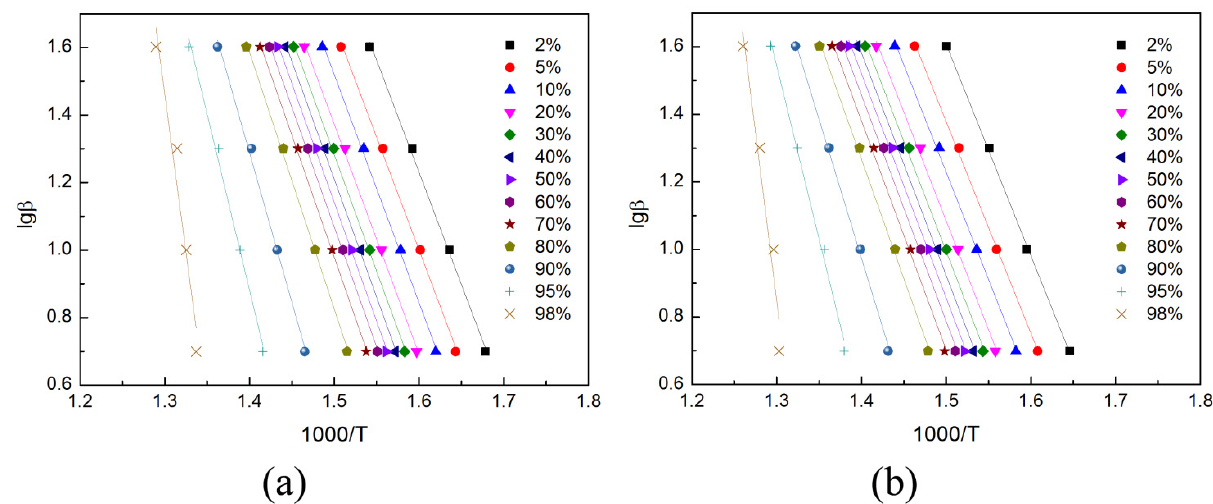
Figure 7. Conversion of ( a ) EP and ( b ) FREP in function of temperature.